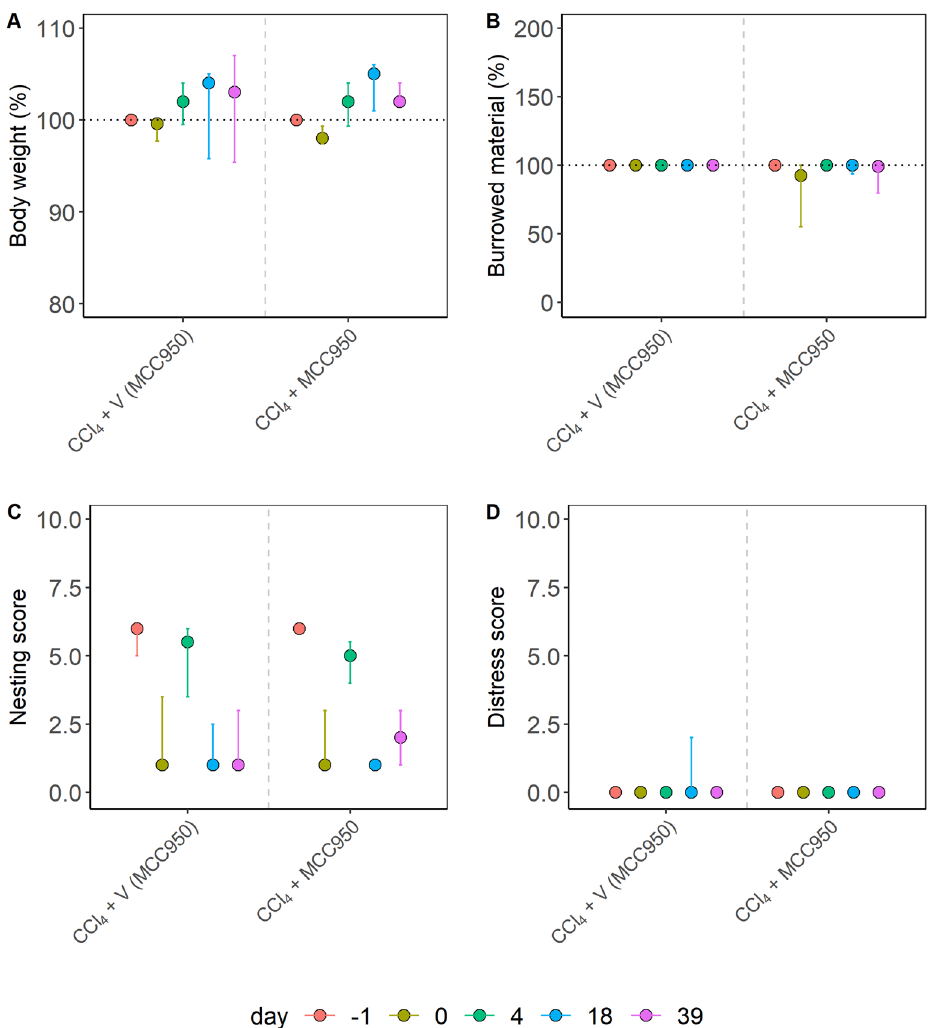
Figure 3. Distress evaluation of liver damage in a fibrosis model. Liver damage was induced by repetitive carbon tetrachloride application (CCl 4 ), and mice were treated with an NLRP3 inflammasome inhibitor (MCC950) or the appropriate vehicle solution (V). The percentage of body weight ( A ), the percentage of burrowing activity ( B ), the nesting ( C ), and the distress score ( D ) were evaluated on the indicated days. No significant differences between the groups were found using the Kruskal–Wallis test in ( A ) ( χ 2 = 0.48, df = 1, p = 0.49), ( B ) ( χ 2 = 1.33, df = 1, p = 0.25), ( C ) ( χ 2 = 0.047, df = 1, p = 0.83) or ( D ) ( χ 2 = 2.33, df = 1, p = 0.13). The graphs depict the bootstrapped median estimator on each experimental day and the 95% confidence intervals. ( A ) MCC950: n = 13, vehicle: n = 9; ( B ) MCC950: n = 7, vehicle: n = 3; ( C ) n = 6, vehicle: n = 6. ( D ) MCC950: n = 7, vehicle: n =